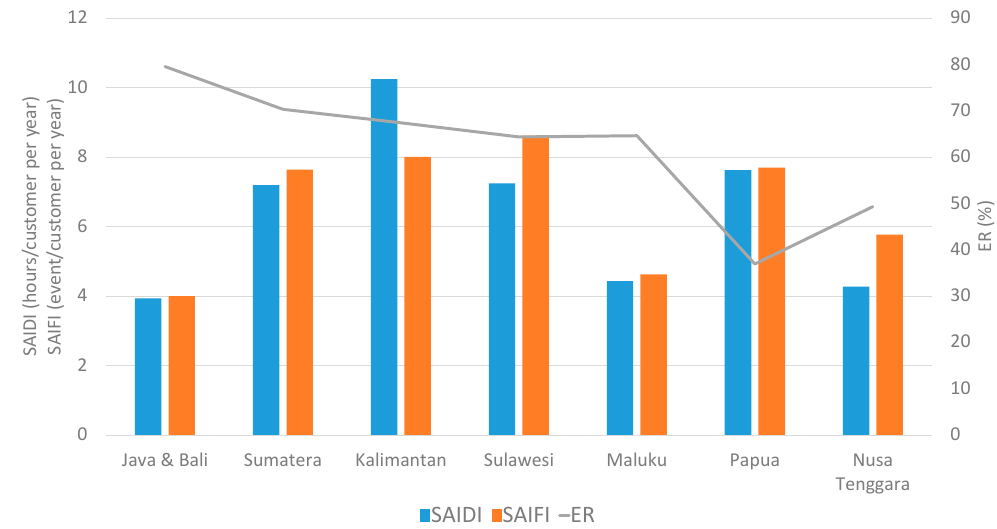
Figure 10. Correlations between SAIDI (blue bar) and SAIFI (orange bar), the electrification ratio (grey line), and SAIFI and electrification ratio.